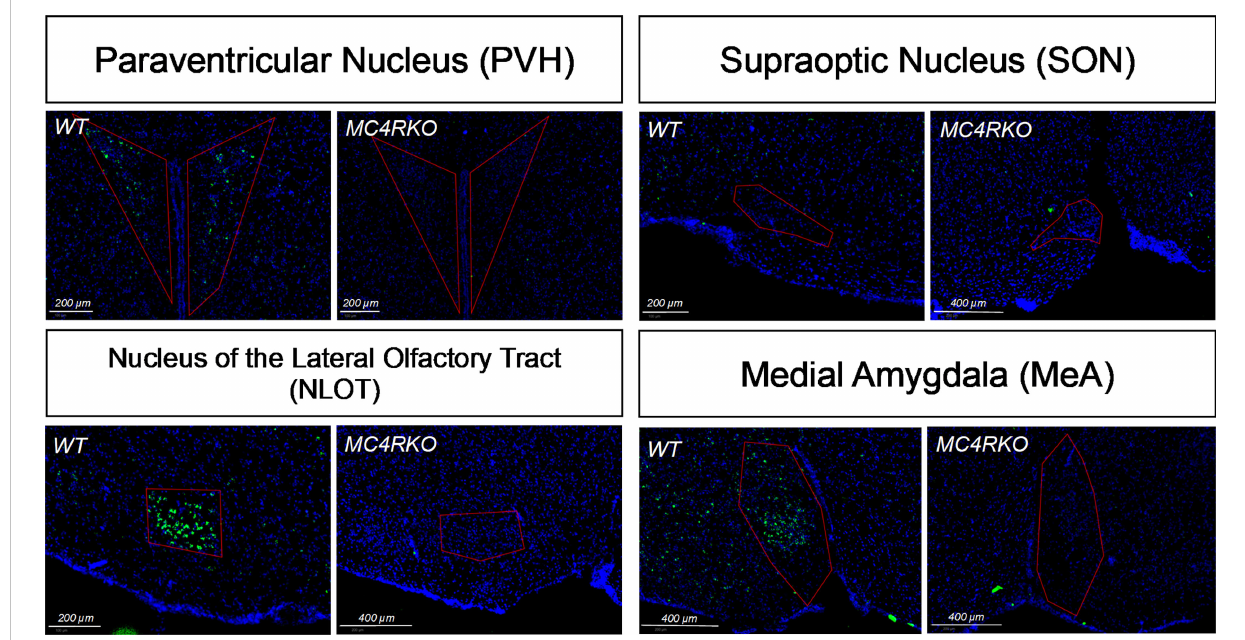
FIGURE 3 In situ hybridization showing lack of MC4R in MC4RKO mice in the paraventricular hypothalamus (PVH), the nucleus of the olfactory tract (NLOT), and the medial amygdala (MeA). MC4R mRNA is labelled green. Nuclei were labelled using DAPI (blue).